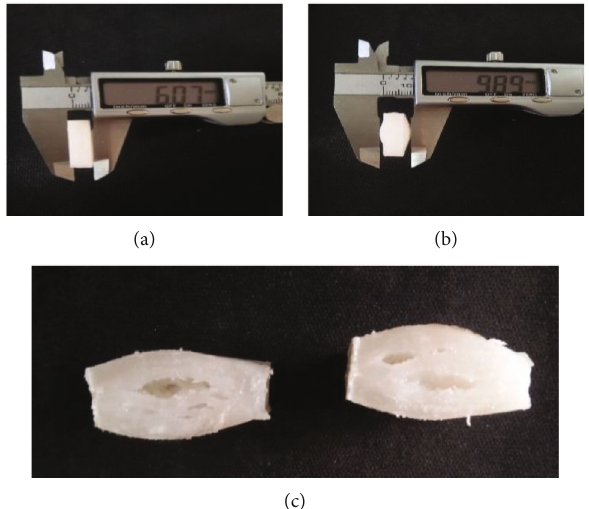
Figure 4: The picture of 60/0 sample: (a) before, (b) after, and (c) cross-sections after immersion in n-hexane.